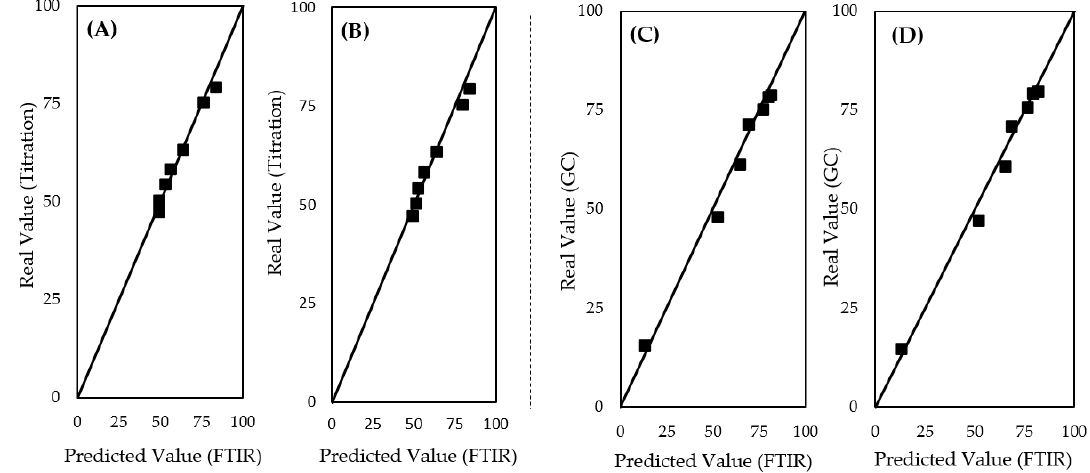
Figure 3. FFA ( A , B ) and FAME ( C , D ) contents in acid oil from soapstock predicted by FTIR spectroscopy against real values (titration method and gas chromatography (GC) method). ( A ) Abs (FTIR) = 0.0146 × %FFA + 0.4538; ( B ) Abs (FTIR) = 0.0153 × %FFA + 0.4255; ( C ) Abs (FTIR) = 0.0120 × %FAME + 0.2239; and ( D ) Abs (FTIR) = 0.0124 × %FAME + 0.1802. Line of unit slope represents zero error between experimental and real results.